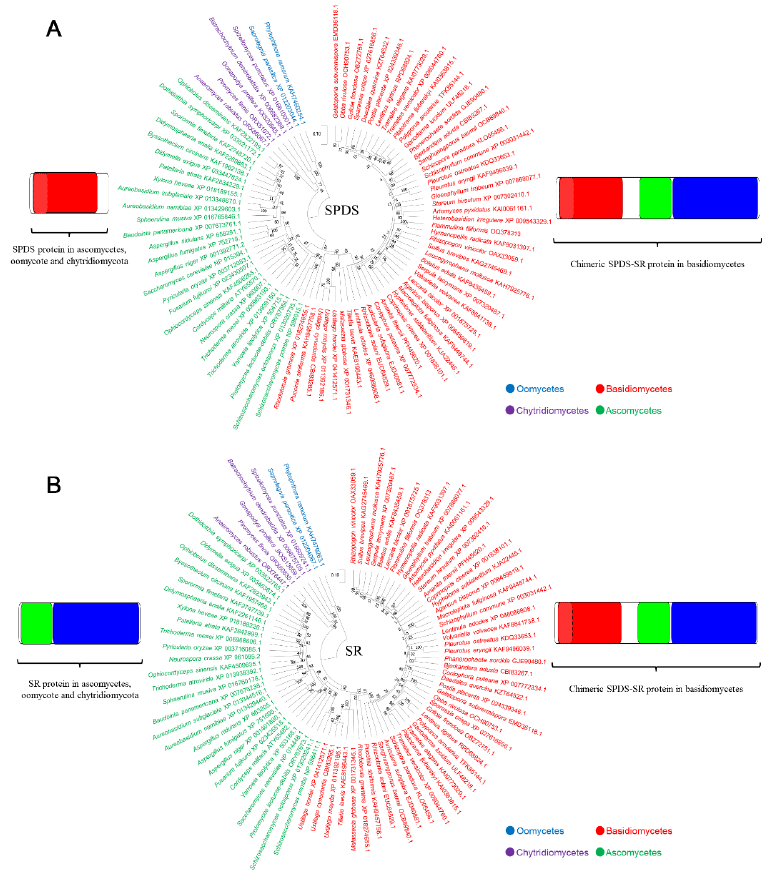
Figure 3. Phylogenetic analysis of SPDS and SR in fungi. ( A ) Phylogenetic trees based on SPDS domain in fungi, including basidiomycetes, ascomycetes, chytrid fungi, and oomycetes. ( B ) Phylogenetic trees based on SR domain in fungi, including basidiomycetes, ascomycetes, chytridiomycetes, and oomycetes.